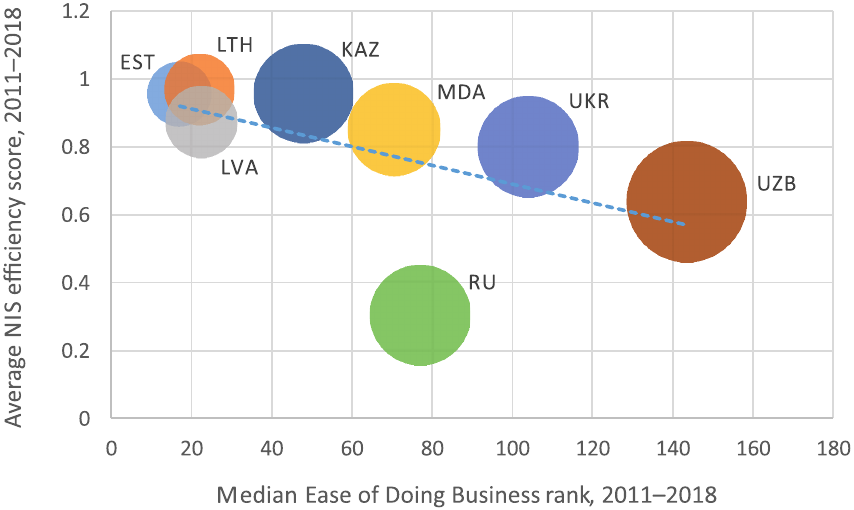
Figure 13. NIS efficiency score vs. EDB rank vs. corruption perceptions index (inverse value, the size of bubbles). NIS efficiency score: 0 means inefficient, 1 means highly efficient. EDB rank: 1 = most business-friendly regulations. Inverse corruption index: 1 = very